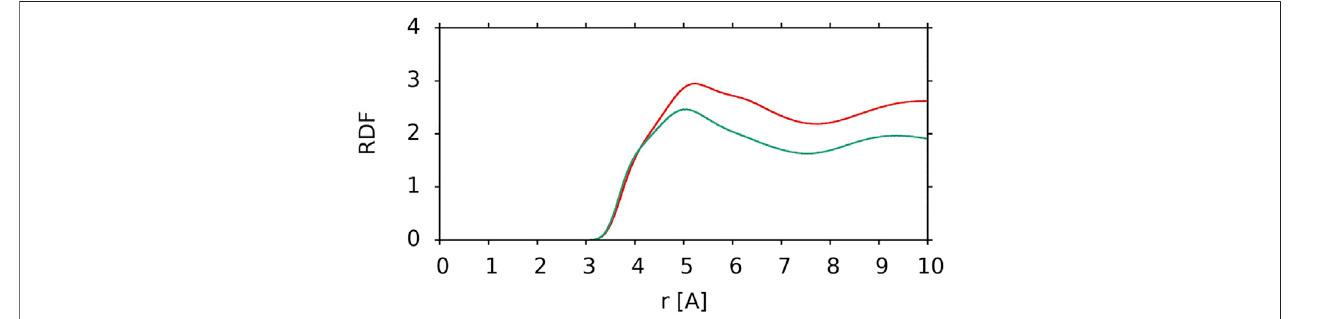
FIGURE 8 | C-C RDF of the lutein polyene chain carbon atoms relative to PC acyl chain carbon atoms for a vertical lutein in the PC-LUT_V bilayer ( red ) and for the horizontal lutein in the PC-LUT_H bilayer ( green ). RDFs are cut at 10 Å.